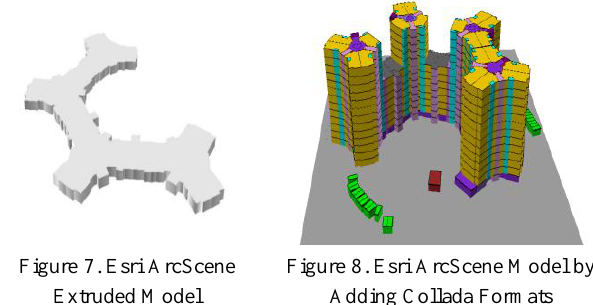
Figure 3. Polygons after modification